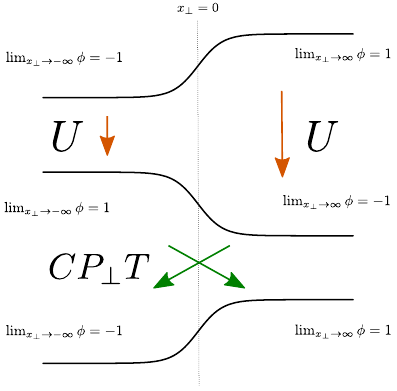
Figure 1: The (cid:90) domain wall is created by imposing frustrated boundary conditions 2 for the order parameter φ along a coordinate x ⊥ or breaking the symmetry with a spatially-varying potential. Indeed, the global symmetry U does not act on the wall but if we combine it with CP ⊥ T , a canonical symmetry which involves a reflection in the normal coordinate x ⊥ , then we obtain a symmetry of the domain wall degrees of freedom, which is anti-unitary if U is unitary and vice